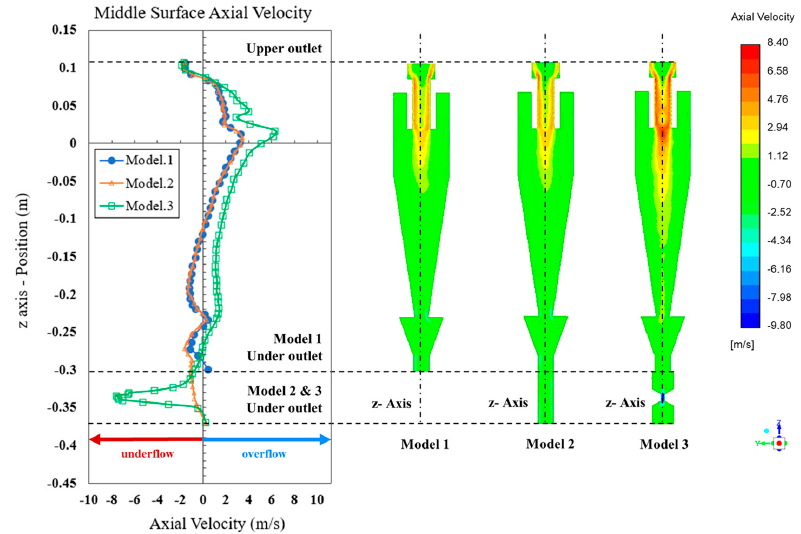
Figure 10. Contour and pro fi le of Axial velocity for the cyclone models.